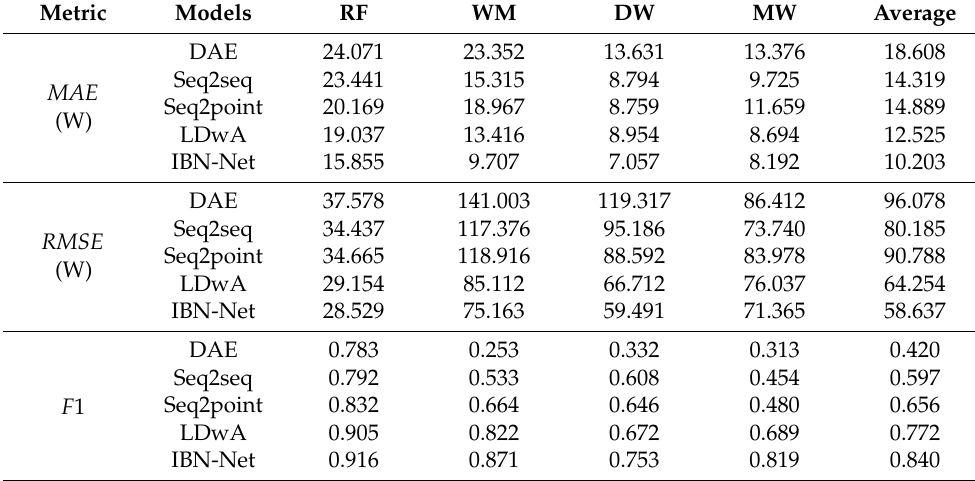
Table 1. Comparison of experimental results of several